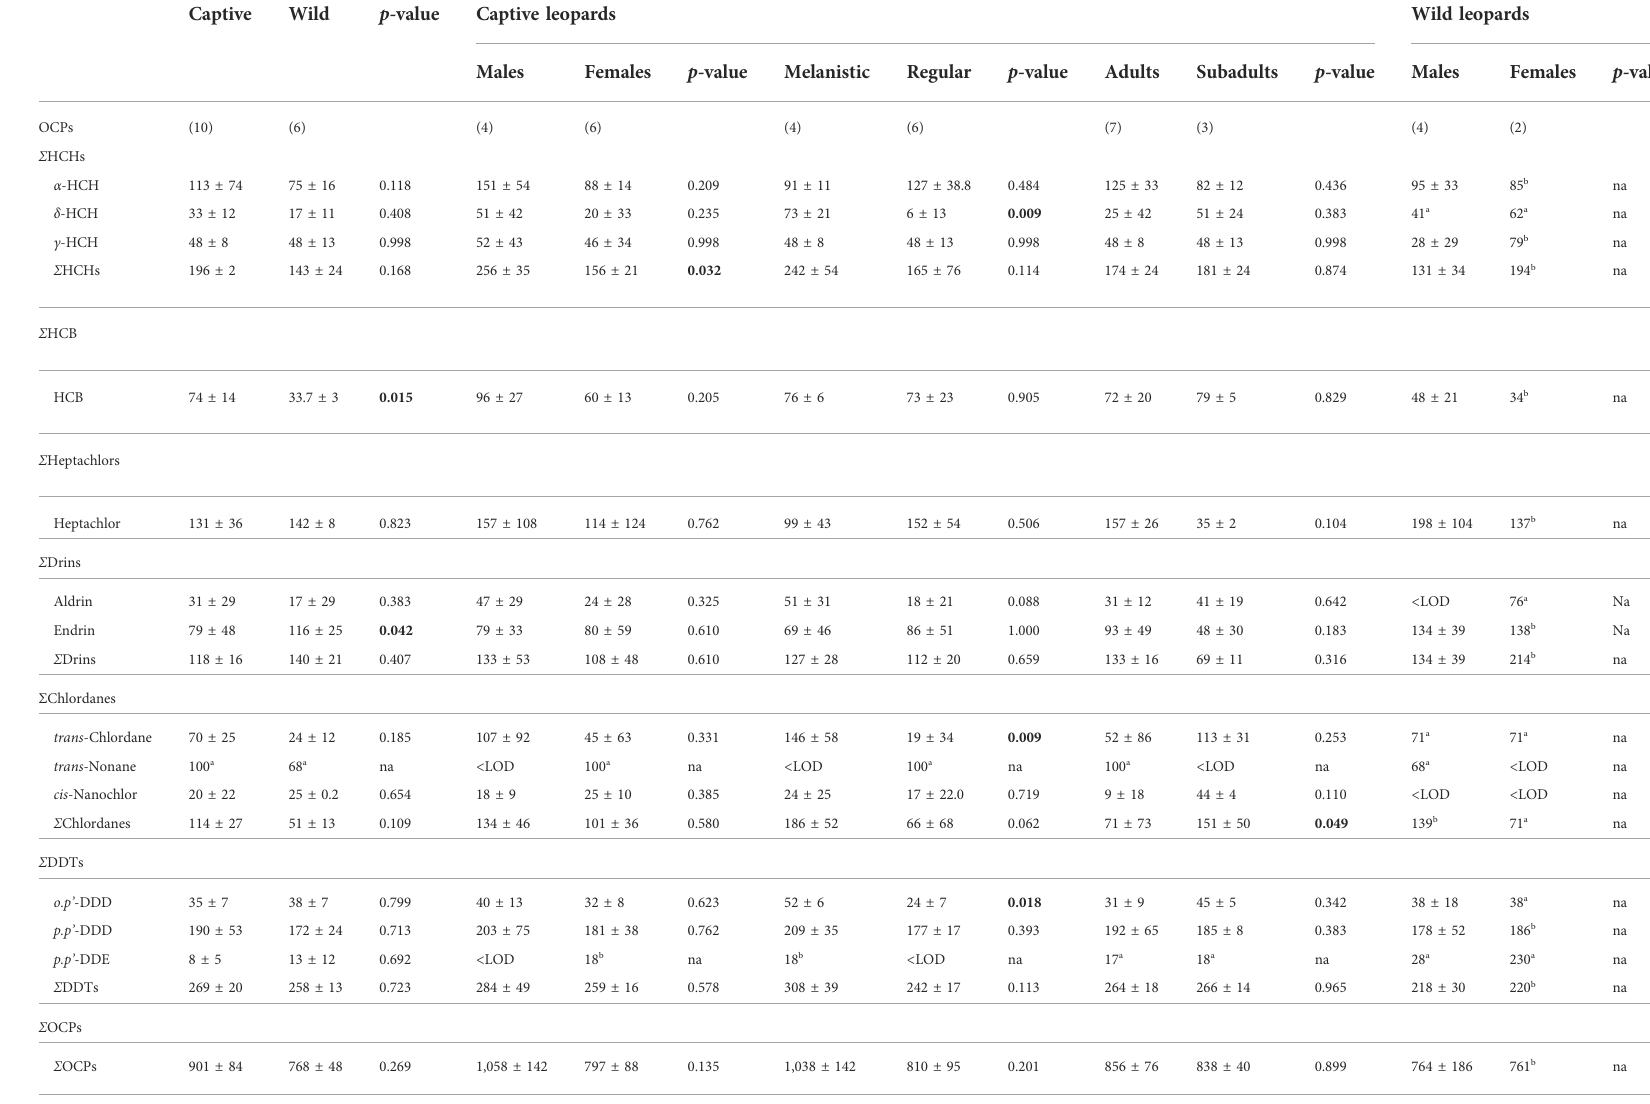
TABLE 2 Organochlorine concentrations (pg/ml) in serum samples from wild and captive leopards. The sample size (n) is presented in brackets. Bold p -values indicate a signi fi cant difference p < 0.05. < LOD, below limit of detection. Na, not applicable.